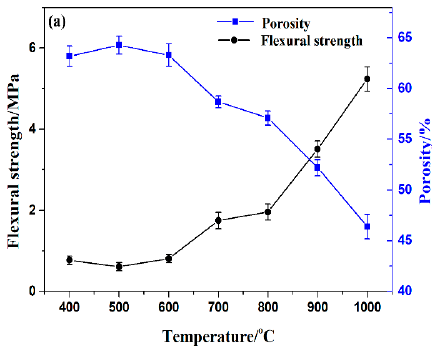
Figure 12. Porosity and flexural strength of the sintered specimens sintered at various temperatures.